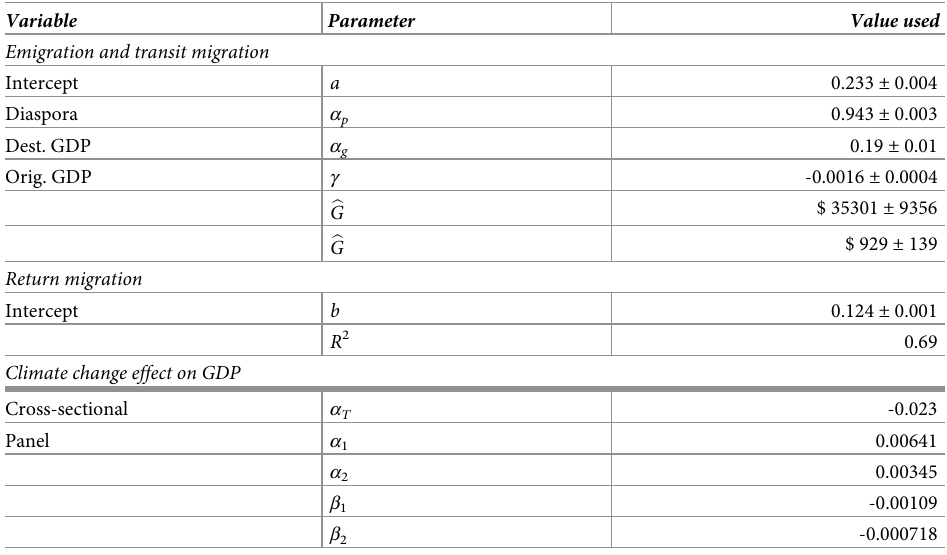
Table 1. Migration model and climate change effect